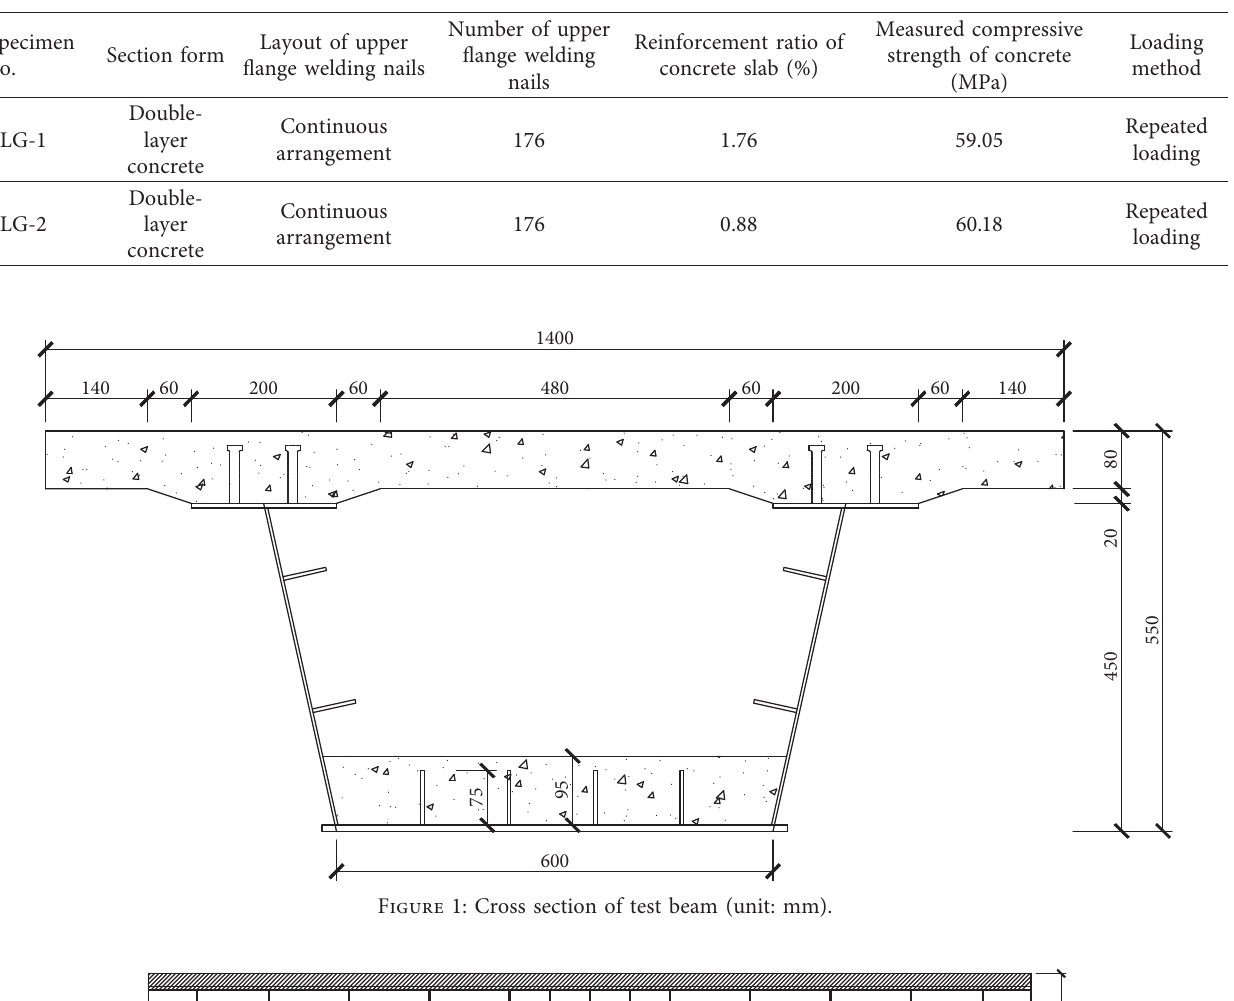
Table 1: Parameters of composite beam specimens.